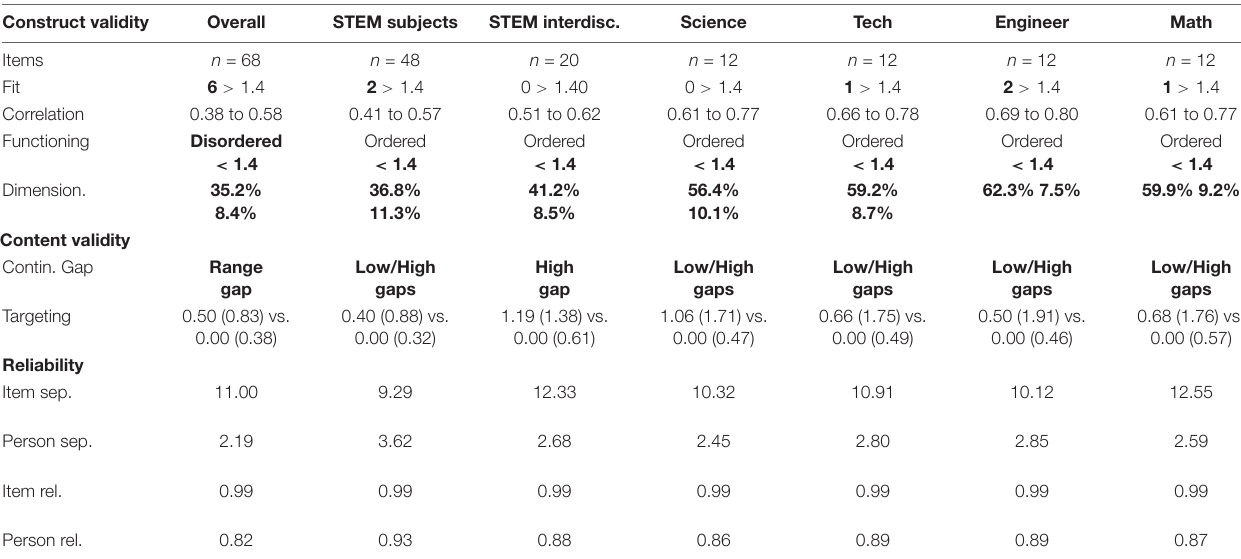
TABLE 2 | STEM student attitude subject survey validity and reliability